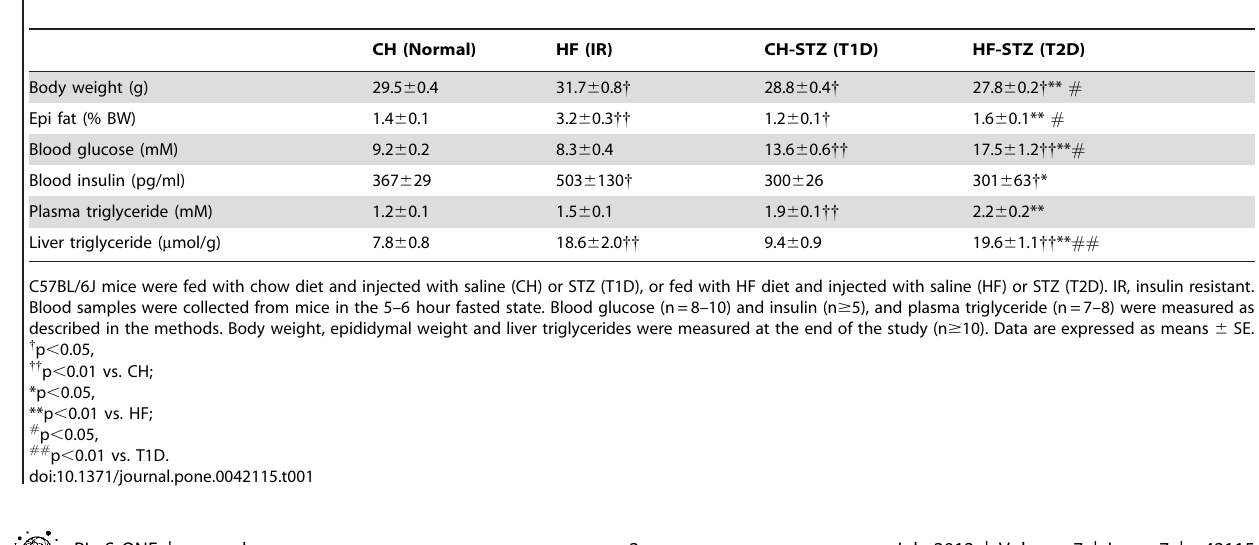
Table 1. Metabolic characteristics of the type-1 and type-2 diabetes mouse